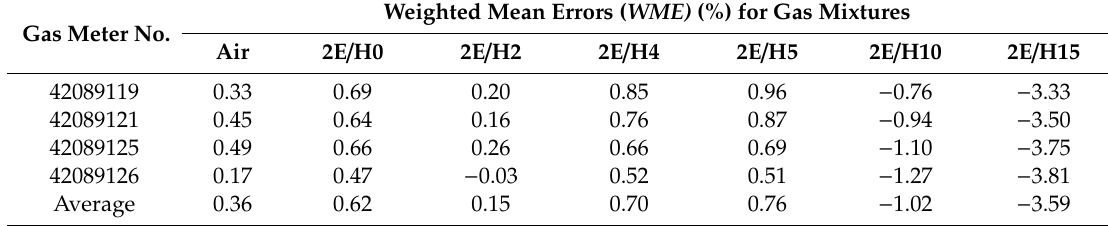
Table 6. The weighted mean errors ( WME ) of thermal gas meters for gas mixtures. Gas Meter No.